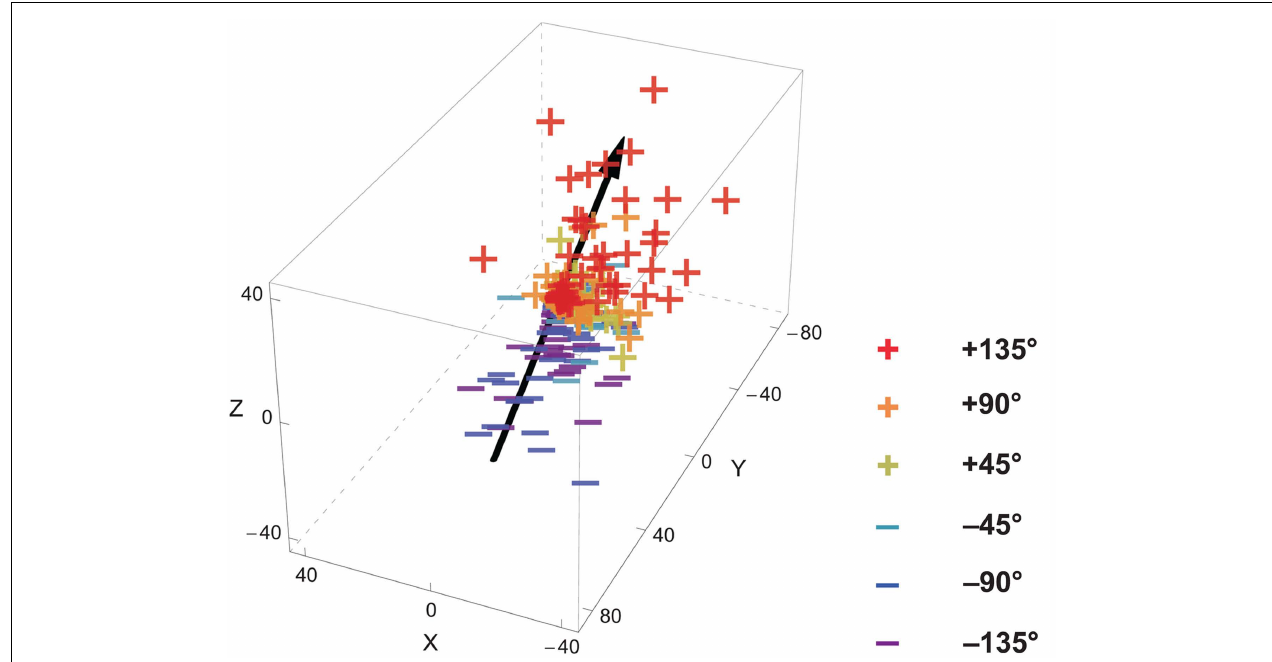
FIGURE 3 |An example of participant’s maximum head rotation vectors for all trials and the computed head rotation axis. The “ + ” and “ − ” depict the terminal points of the maximum rotation vectors (see Figure 2 ) for trials with respectively positive and negative deviation angles.The black line